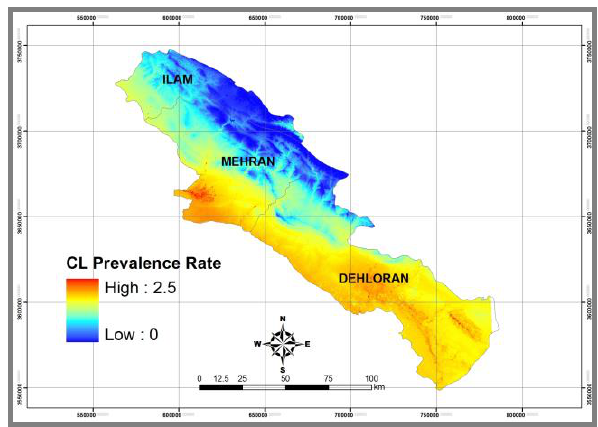
Figure 6. Predicted risk map of Ilam in 2012